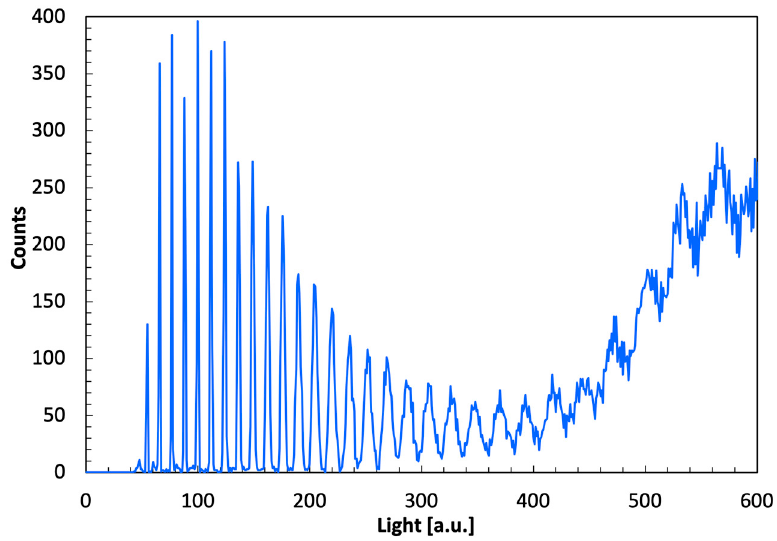
Figure 5. Lower-energy part of the spectrum obtained by exposing the detector to a 22 Na source. Thirty very well resolved peaks corresponding to discrete numbers of scintillation photons detected by the SiPM are clearly observable.